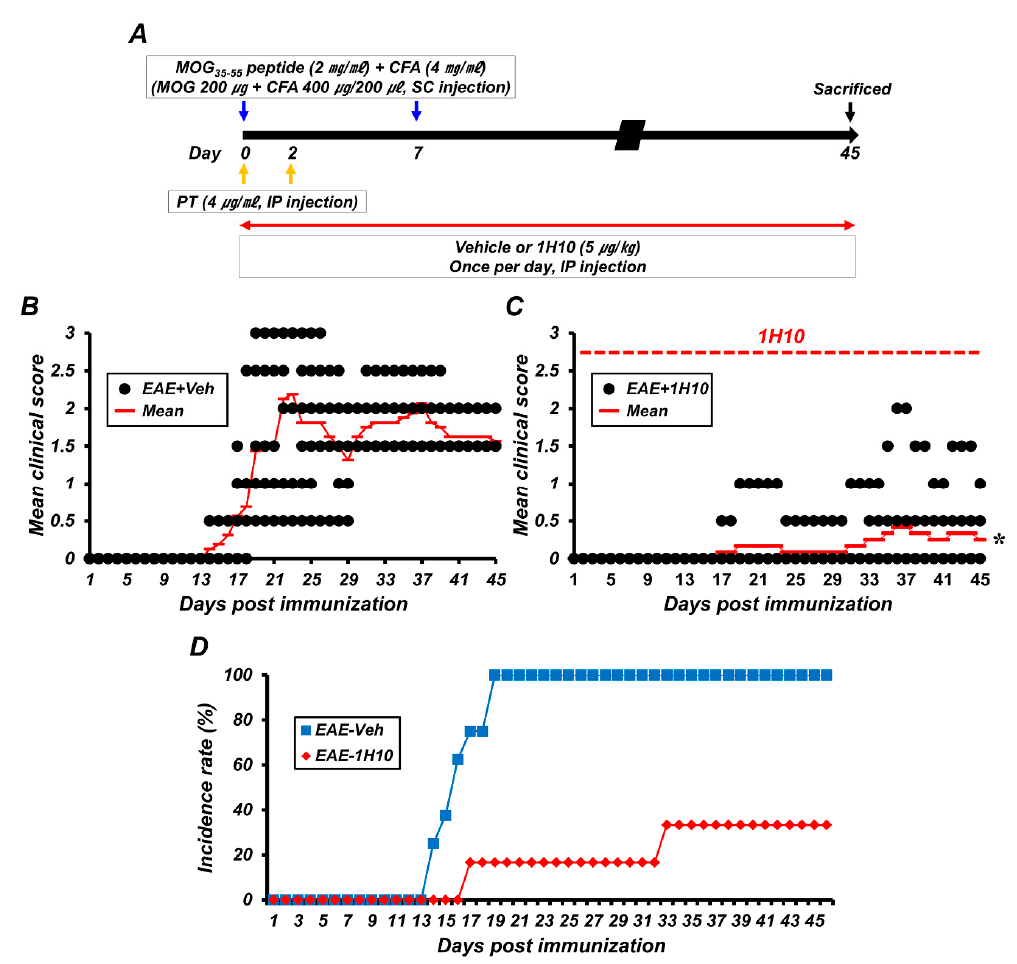
AMPK α 1/2. ( H ) Quantitative colocalization parameters of CD8 with phospho-AMPK α 1/2 determined by measuring Mander’s overlap coefficient (mean ± SEM; n = 4 per group). * p < 0.05 vs. vehicle-treated EAE mice (unpaired Student’s t -test).